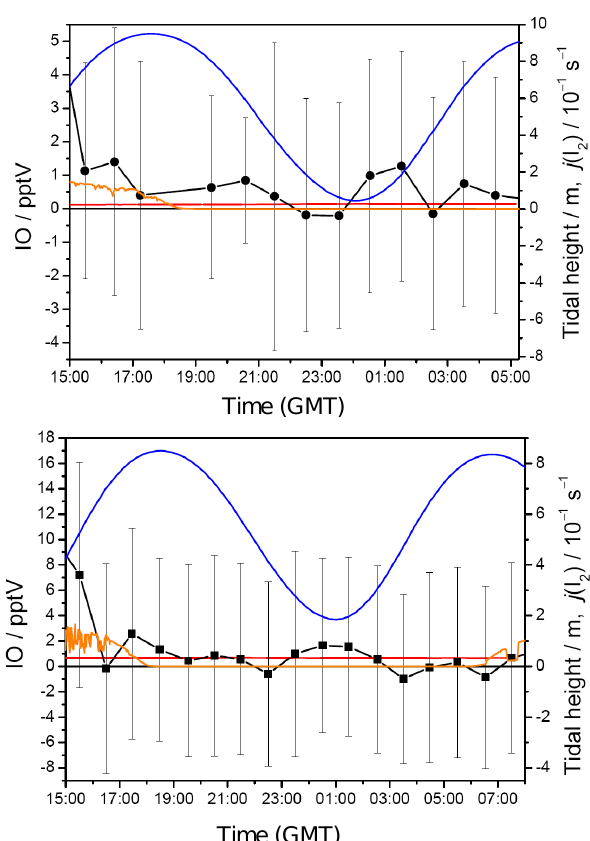
Fig. 10. Night-time measurement of IO on the nights of 8th (top) and 25th (bottom) September. The filled circles (top) and filled squares (bottom) represent IO (60 minute average, black line represents 60 minute running average, error bars represent the 23% 1 σ calibration error combined with the 1% error from the normalisation and the 1 σ precision of the normalised signal), the red line represents the 60 minute limit of detection, the orange line represents j (I 2 ) and the blue line represents tidal height.